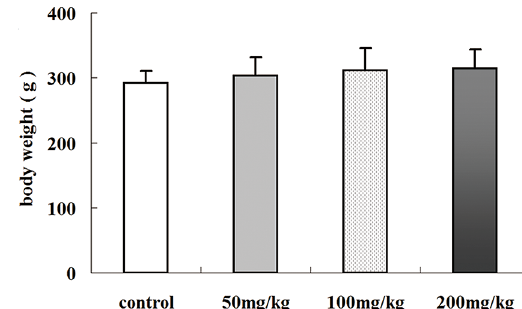
Figure 1. Effects of icariin on the body weight of SD rats after treated with different doses of icariin. Values are the mean ± SD of 10